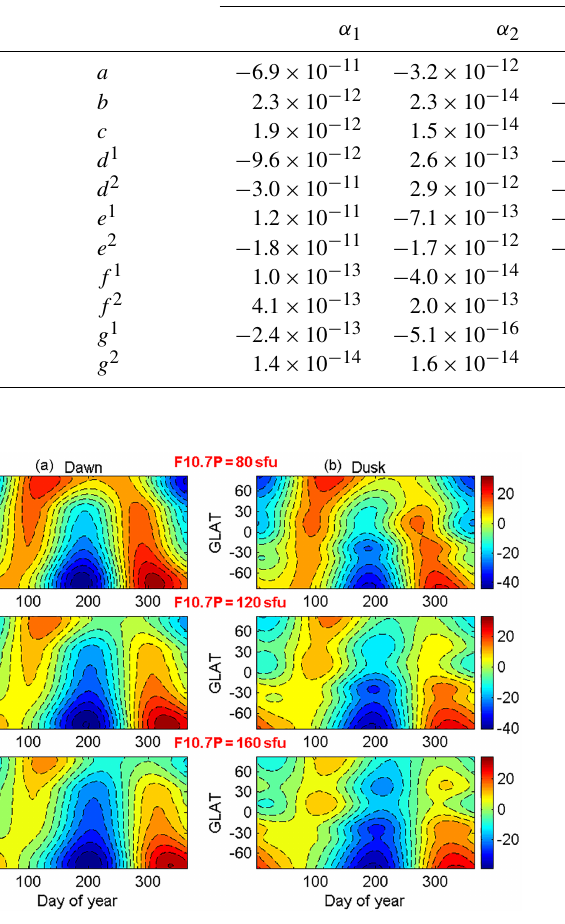
Table 2. The coefficients of the EOF coefficients in Eq. (4) at the dawn and dusk LST sectors. Serial number